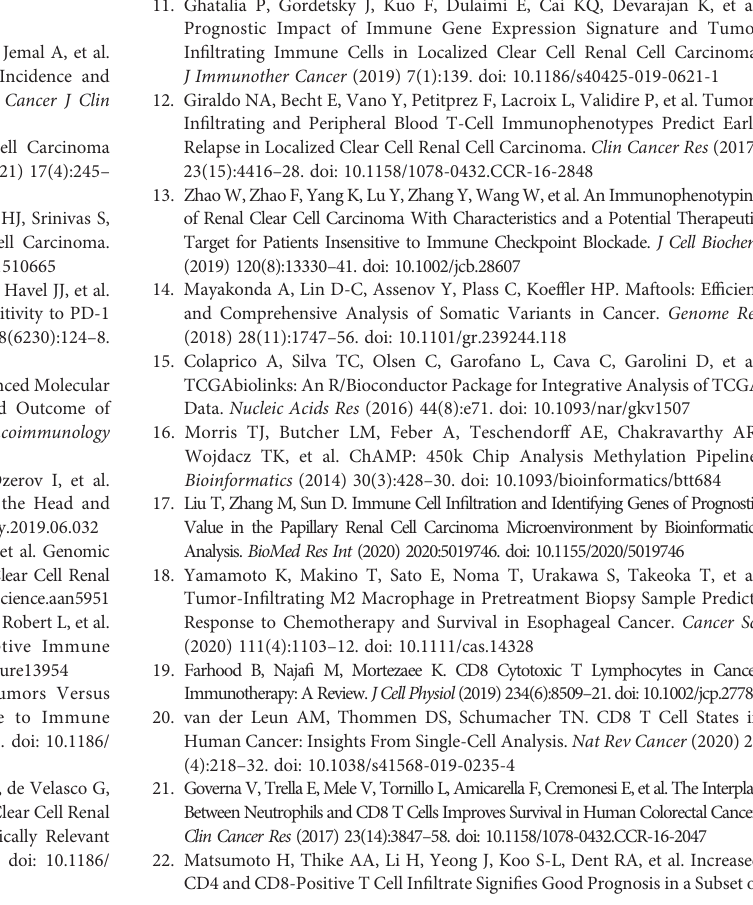
Supplementary Figure 1 | Prognostic model based on DEGs between A1 and B1 with the cut-off set as | log2(fold change)| > log2(1.5), p- value < 0.05. Supplementary Figure 2 | Prognostic model based on intersection of DEGs between A1 and B1 and signi fi cant genes associated with reponse to PD1 therapies in cohort GSE67501(n=11). Supplementary Table 1 | Genes with signi fi cant CNV variations between A1 and